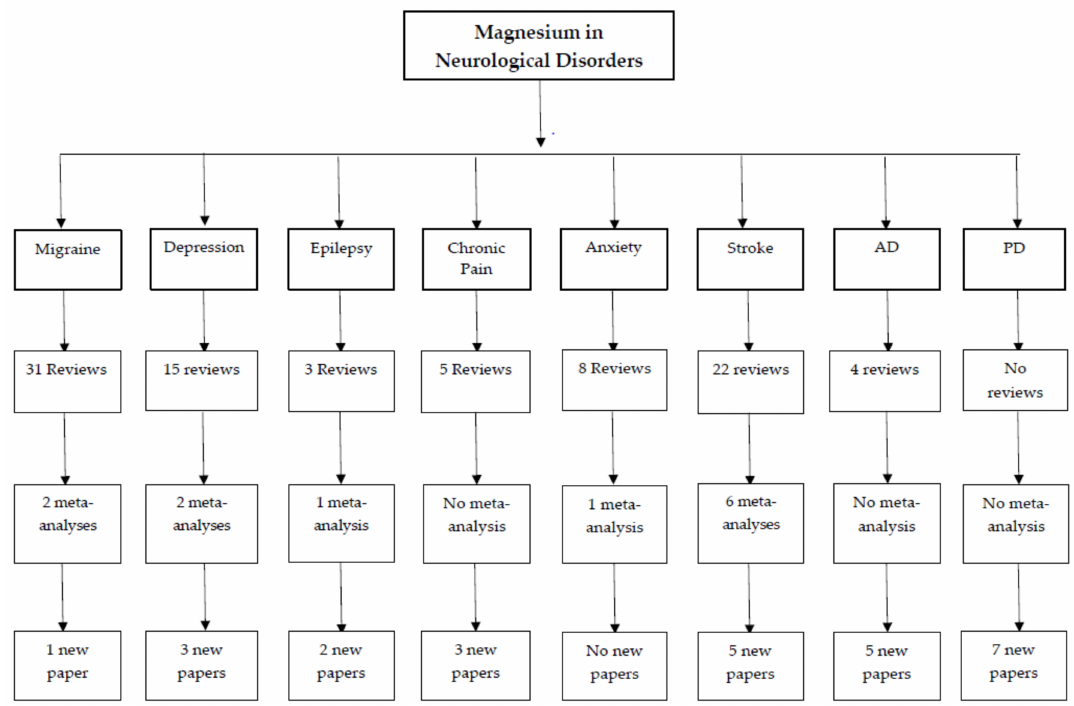
Figure 2. Flow chart of magnesium in neurological disorders literature. New papers refer to published research not included in previously-published reviews and meta-analyses. AD = Alzheimer’s Disease; PD = Parkinson’s